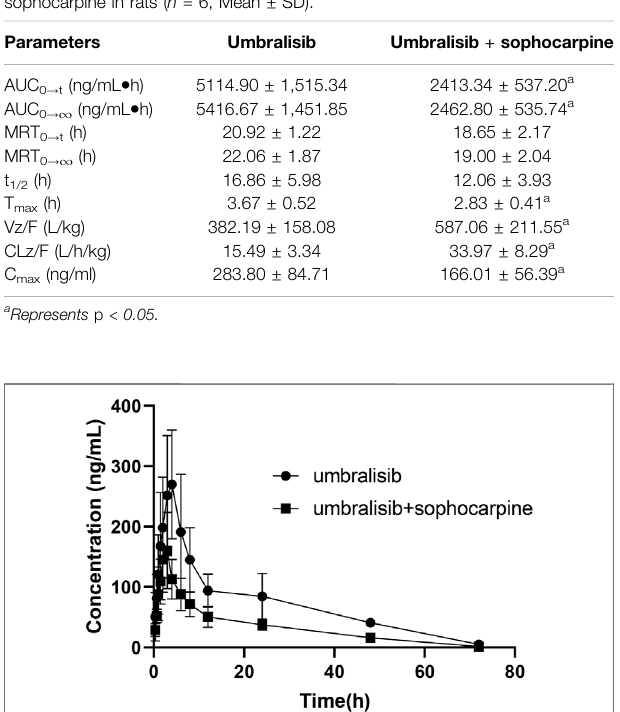
Frontiers in Pharmacology |